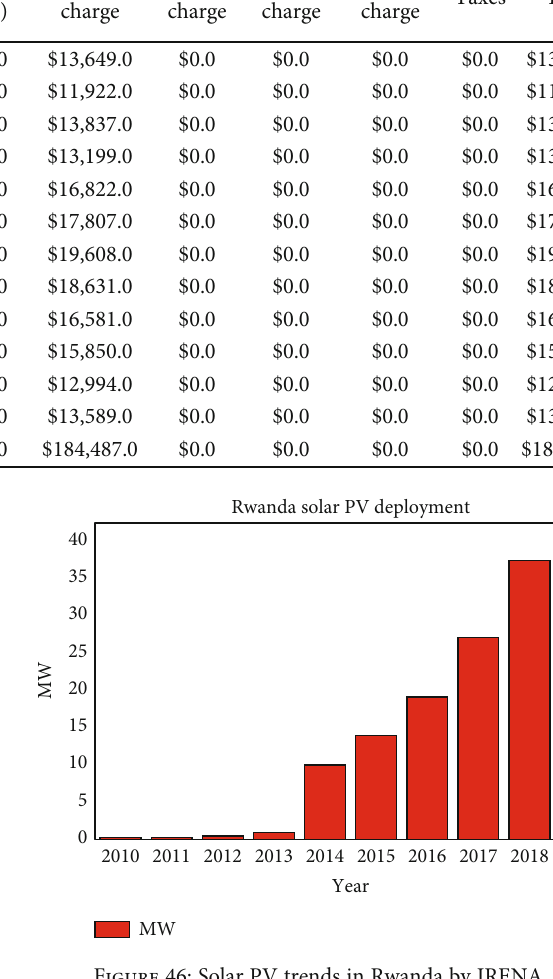
Figure 46: Solar PV trends in Rwanda by